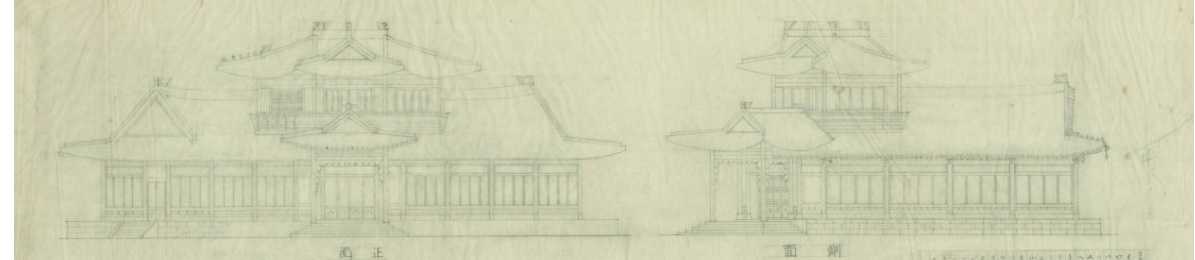
Figure 26. Elevation of the Korea Pavilion at the 1929 Sh ō wa Exposition (Plans J and K are section drawings of the same building) (Source: National Archives of Korea) [5].